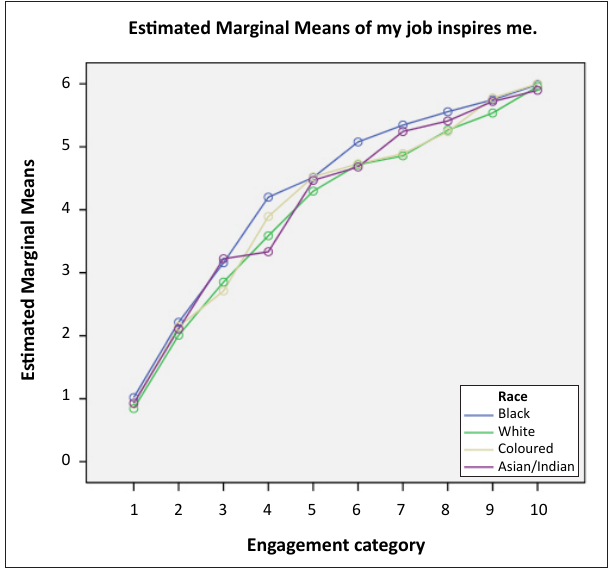
FIGURE 3: Race group mean differences in terms of engagement categories for item 7.